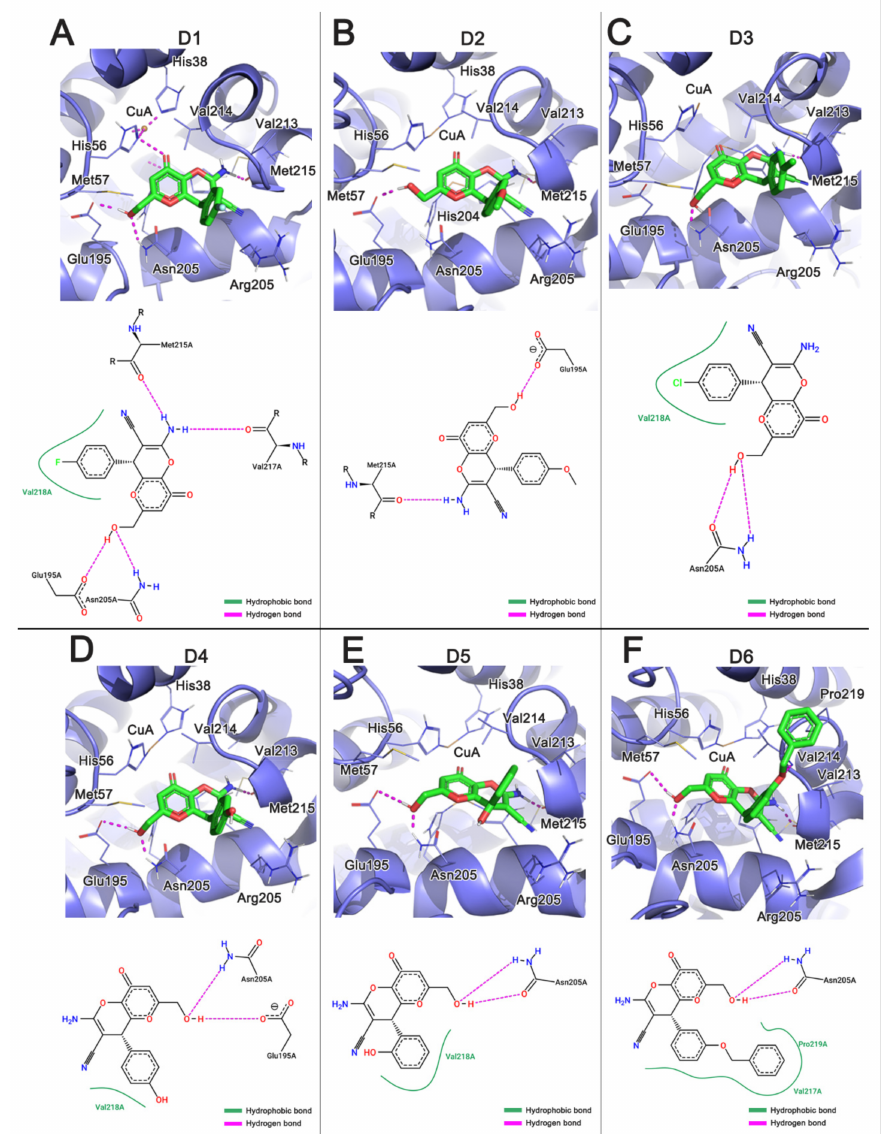
Figure 4. Intermolecular interactions obtained from molecular docking of KA and its derivatives against the tyrosinase binding pocket. ( A ) Derivative D1; ( B ) D2; ( C ) D3; ( D ) D4; ( E ) D5; ( F )